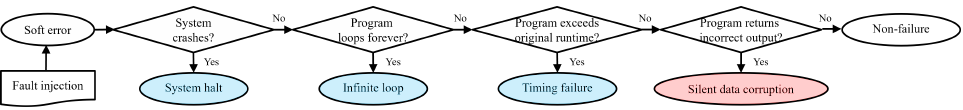
Figure 5. Our experimental setup to prove the efficacy of critical variable protection